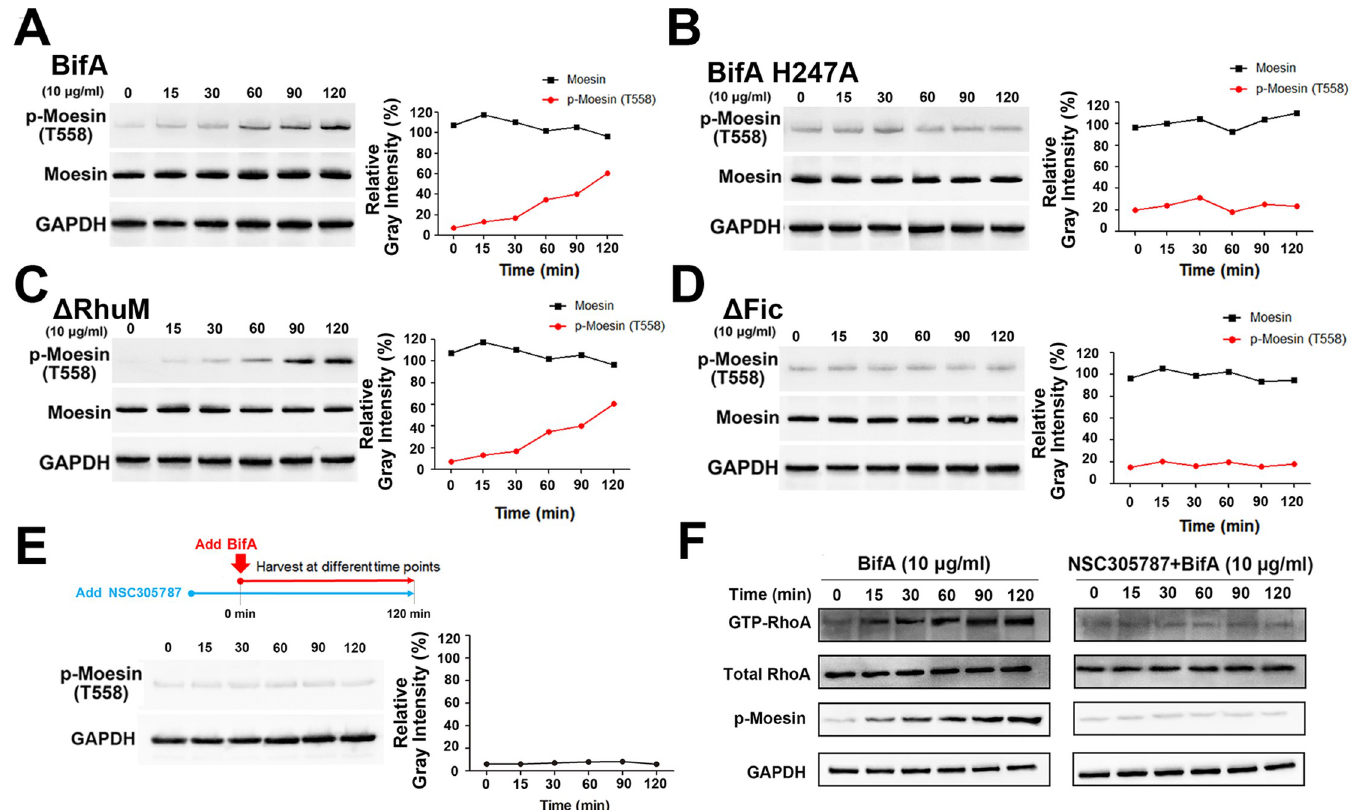
Fig 5. BifA leads to moesin T558 phosphorylation. (A-D) Western blot detection of moesin phosphorylation upon BifA treatment. Human BMEC cells were incubated with different BifA variants for the indicated times and lysates were probed with appropriate antibody. GAPDH is a loading control. The graphs on the right panel show the quantitation of the moesin and phospho-moesin bands by ImageJ, normalized with GAPDH. (E) Effect of PKC inhibition upon BifA induction of moesin phosphorylation. Cells were pre-treated with PKC inhibitor NSC305787 for 30 min before BifA treatment, then analyzed by immunoblot with phospho-moesin antibody. (F) BifA treatment leads to formation of GTP-RhoA. Western blots were performed on lysates of cells treated with BifA alone, or BifA in the presence of NSC305787. Total RhoA and rhotekin protein precipitated GTP-RhoA was detected by anti-RhoA antibody. GAPDH was the loading